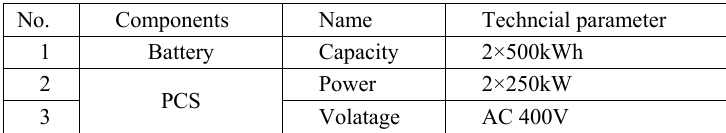
Table 1. 250kW/500kWh energy storage.